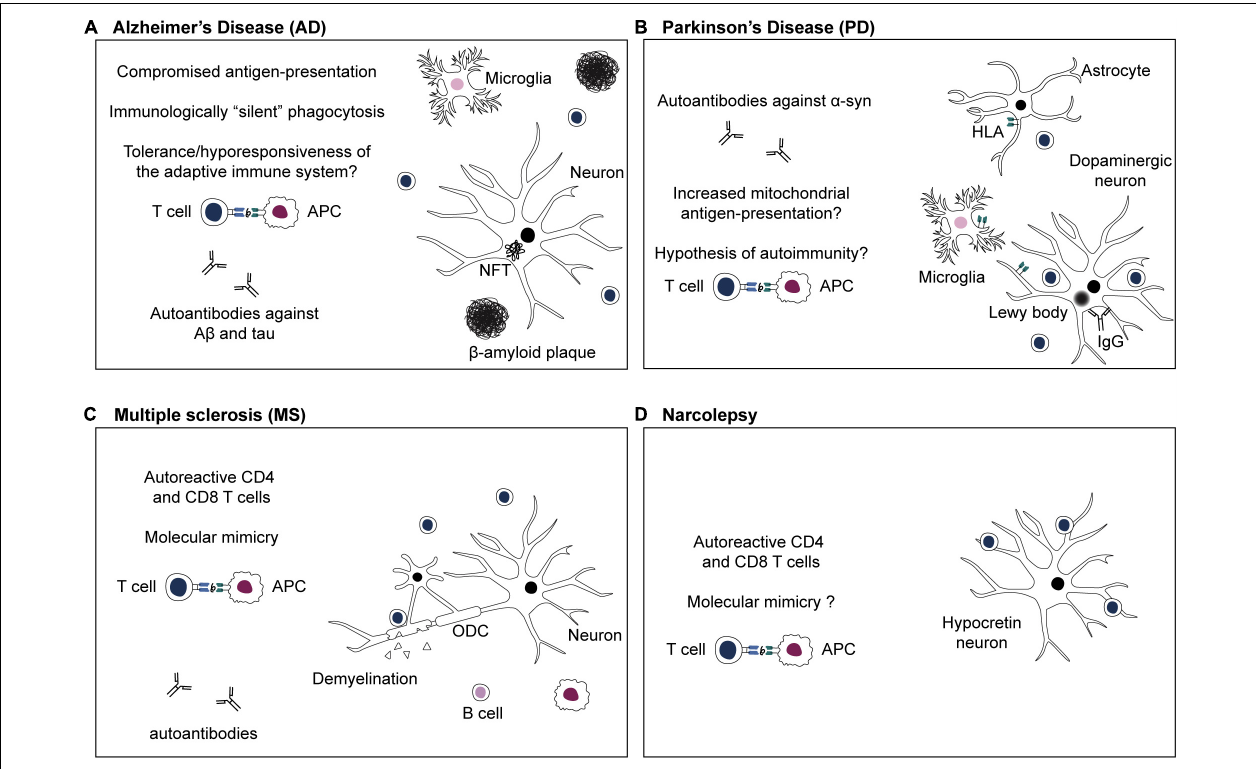
FIGURE 2 | Adaptive immune system in CNS disorders. (A) Alzheimer’s disease: the antigenic targets of infiltrating T cells in the brain during β -amyloidosis and tau pathology are not known yet. Efficient phagocytosis and antigen presentation are compromised in AD (Gu et al., 2016; Gericke et al., 2020). Phagocytosis of A β aggregates might happen in an immunologically “silent” manner, or, chronic exposure to A β -derived self-peptides and tolerance mechanisms might lead to a hyporesponsiveness of the adaptive immune system (Monsonego et al., 2001; Ferretti et al., 2016). (B) Parkinson’s disease: targeted antigen-specific T cell infiltration in the brain of PD patients is thought to be due to expression of HLA class II or class I by microglia, astrocytes, and dopaminergic neurons, respectively (Imamura et al., 2003; Cebrián et al., 2014; Rostami et al., 2020). Moreover, defects in PD-associated proteins PINK1 and parkin might increase presentation of mitochondrial antigens, leading to autoimmunity (Matheoud et al., 2016). (C) Multiple sclerosis: numerous studies emphasize the crucial role of autoreactive CD4 and CD8 T cells in MS (Dendrou et al., 2015). Autoreactive T cells infiltrate the CNS and cause demyelination as well as oligodendrocytes (ODC) and neuroaxonal damage (Dendrou et al., 2015). Autoreactive T cells might be activated in the periphery via recognition of viral antigens that are similar to a self-peptide via molecular mimicry (Sospedra and Martin, 2005; Dendrou et al., 2015). (D) Narcolepsy: autoreactive CD4 and CD8 T cells target antigens of hypocretin neurons and